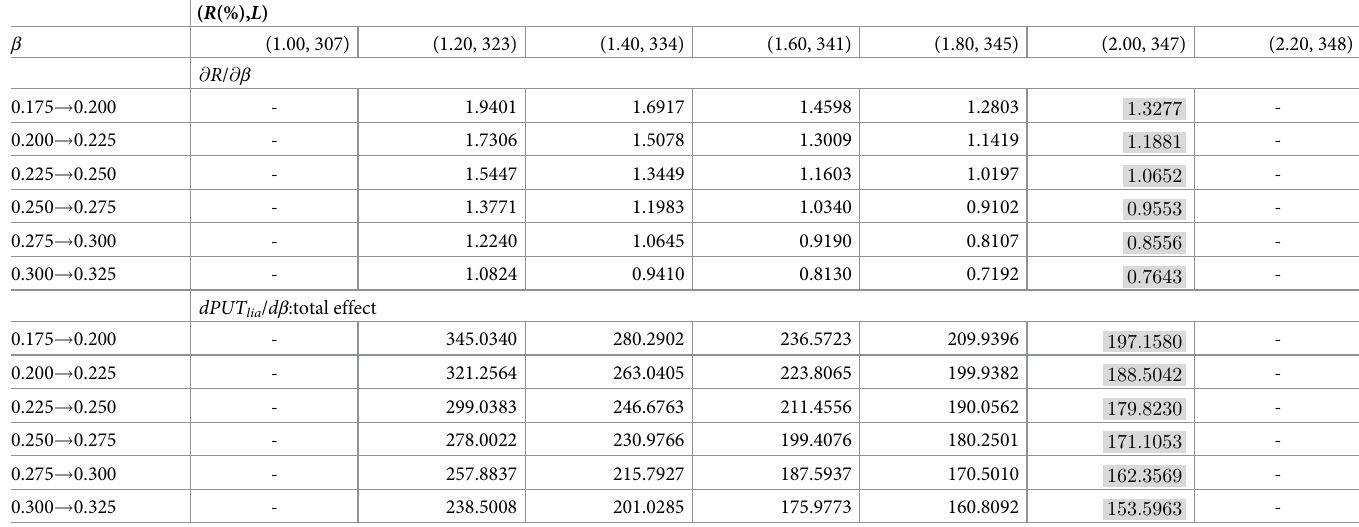
Table 4. Responsiveness of the optimal guaranteed rate and the insurer’s liabilities ( PUT lia ) to affiliated reinsurance ( β